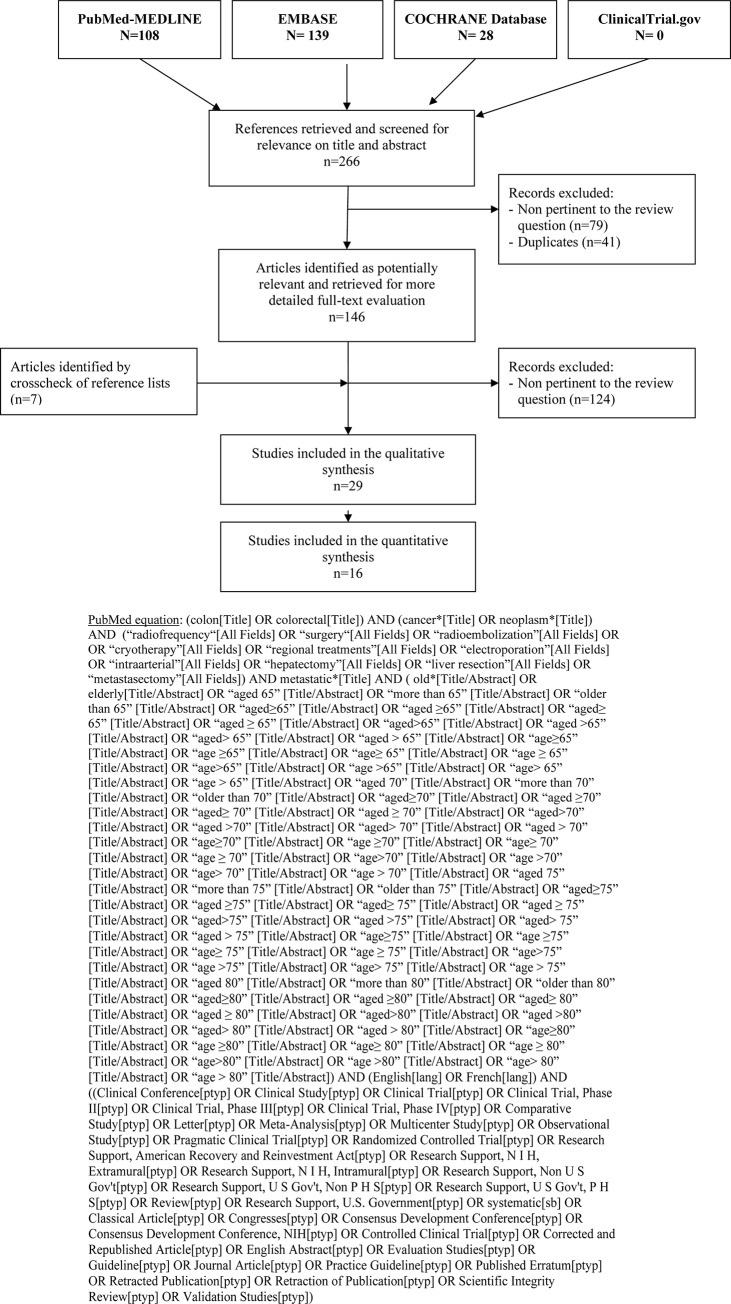
Flowchart of literature search and study selection process.